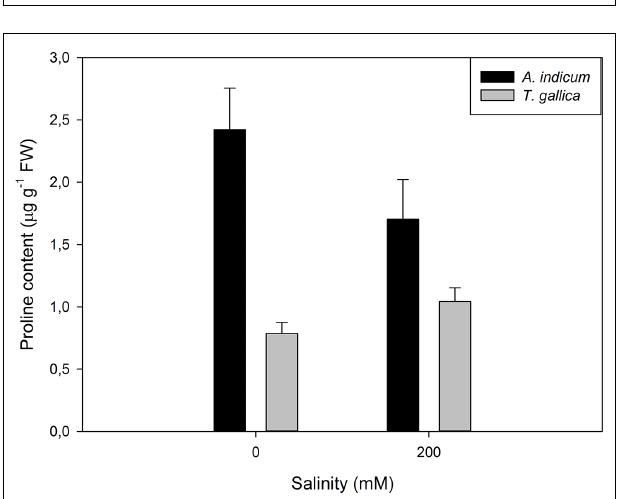
FIGURE 13 | Betain concentration in the leaves of a glycophyte ( Cyperus longus ) and of a halophyte ( Spartina patens ) exposed to a salinity gradient during 1 week (average ± SE, N = 5).